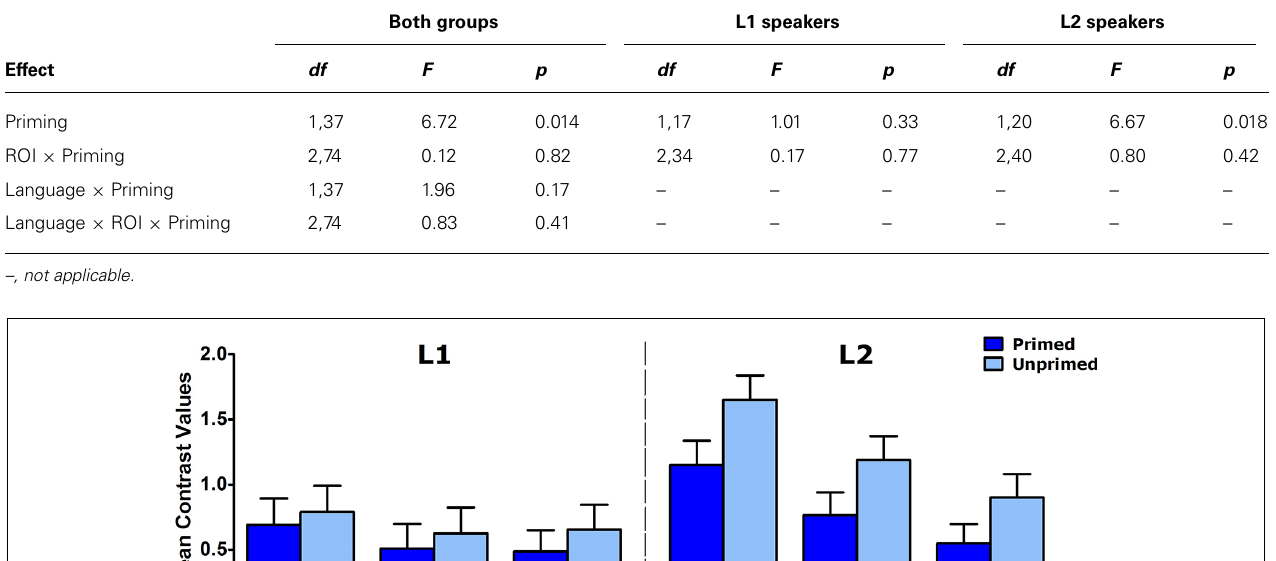
Raftery (1995), this constitutes weak evidence in favor of the null